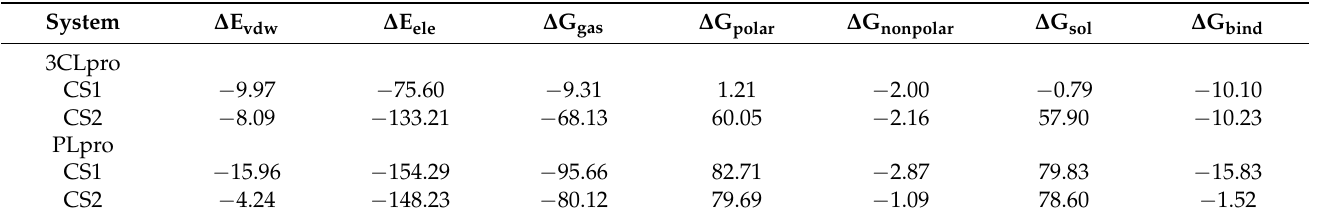
Table 3. Calculated binding free energies and their corresponding components (in kcal mol − 1 ) for the complexes of 3CLpro/PLpro with CS1 and CS2 using the AMBER18